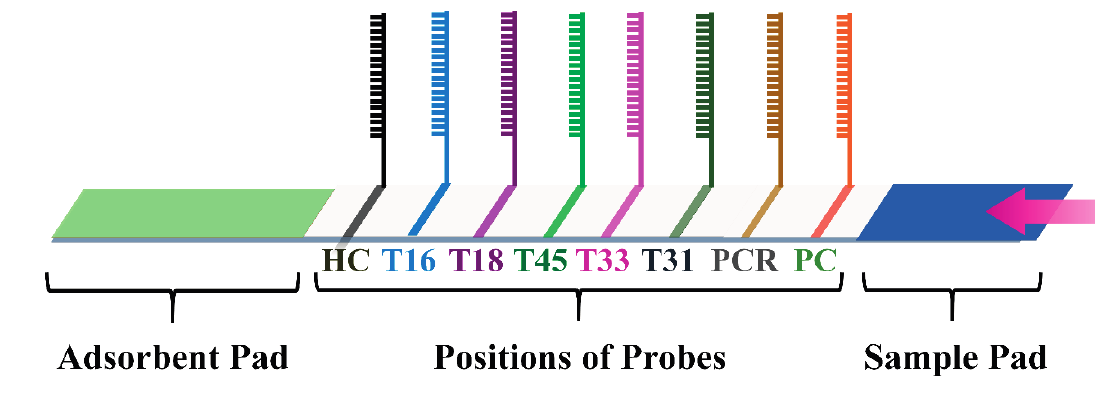
Scheme 2. Positions of the immobilized probes on the membrane.